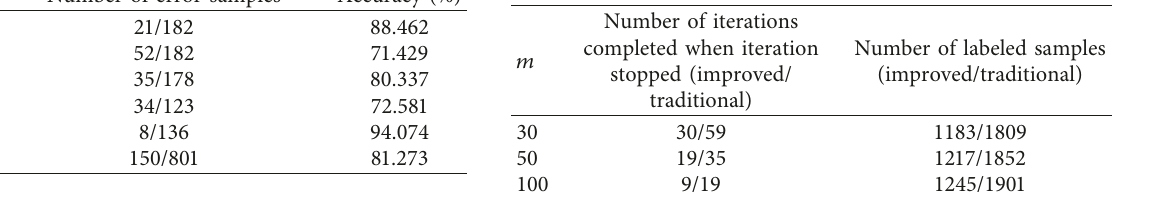
Table 3: Training results of all samples. Table 4: Statistical results (when the iteration stop condition is not 81%).